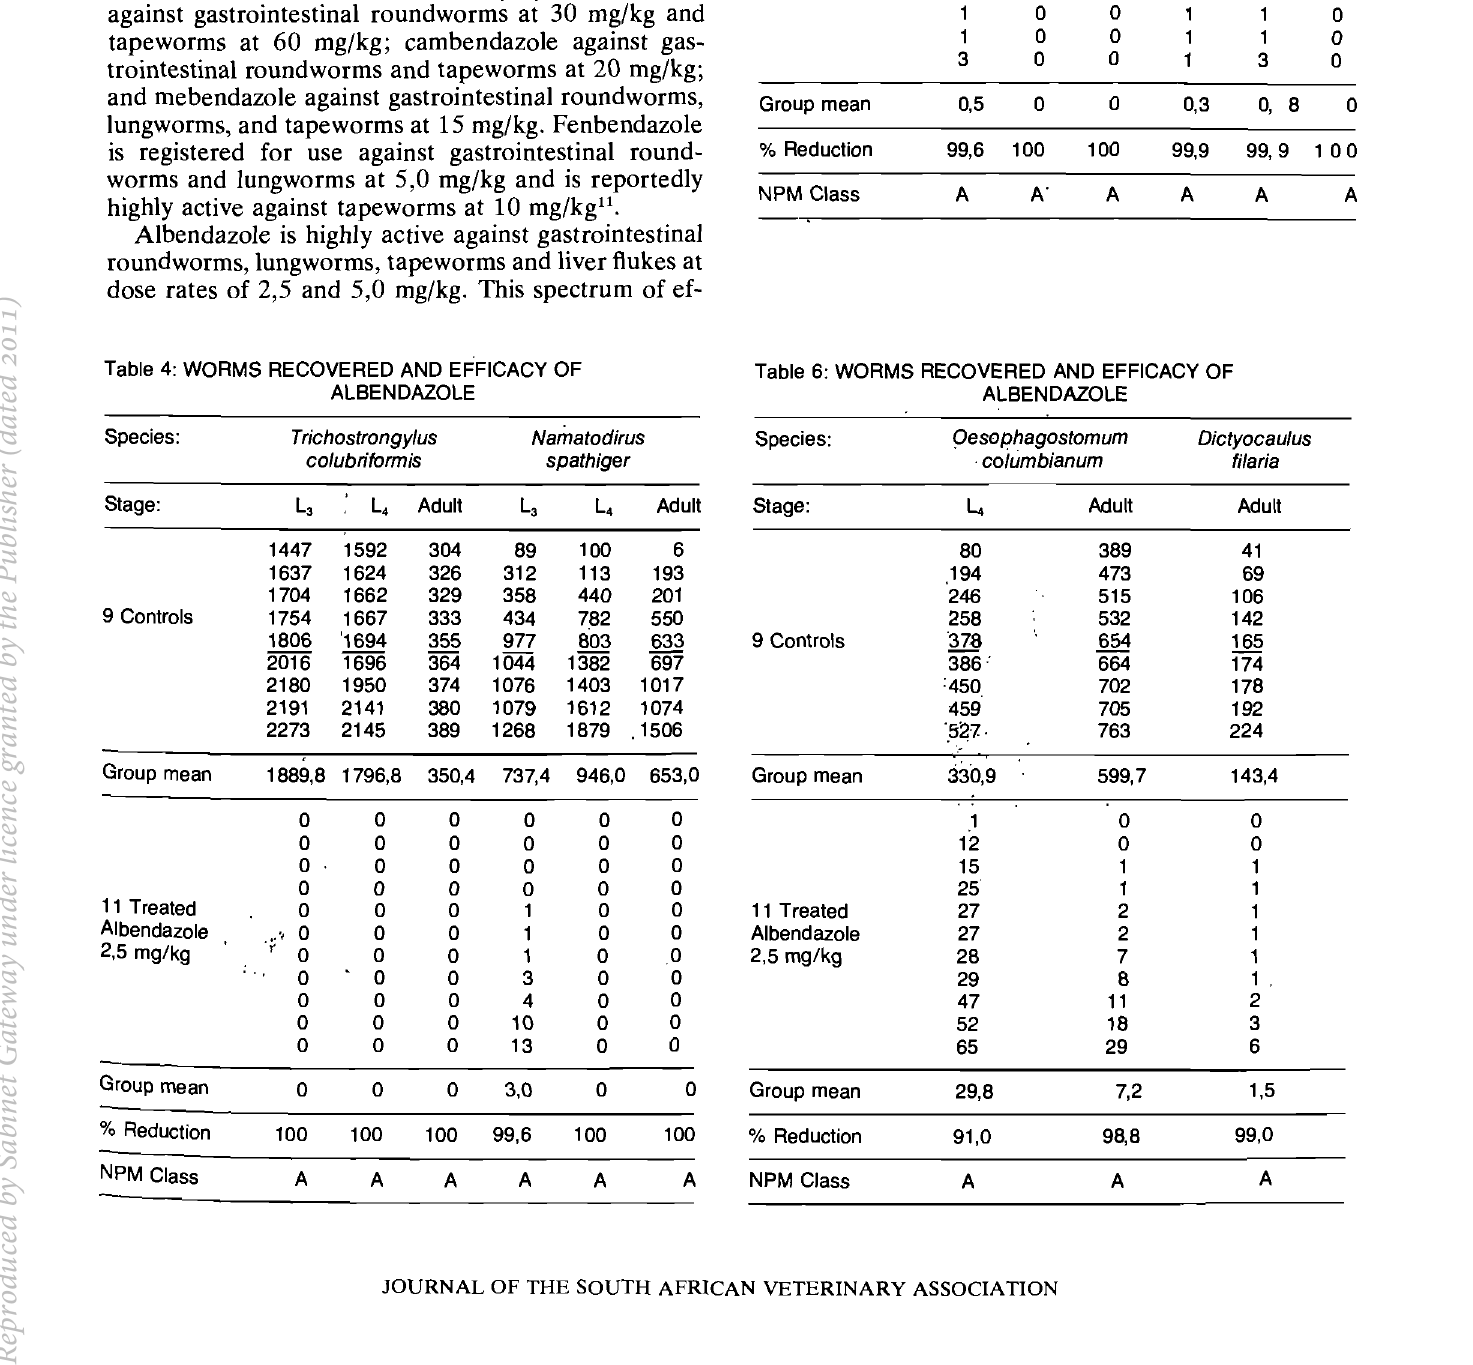
Table 4: WORMS RECOVERED AND EFFICACY OF Table 6: WORMS RECOVERED AND EFFICACY OF